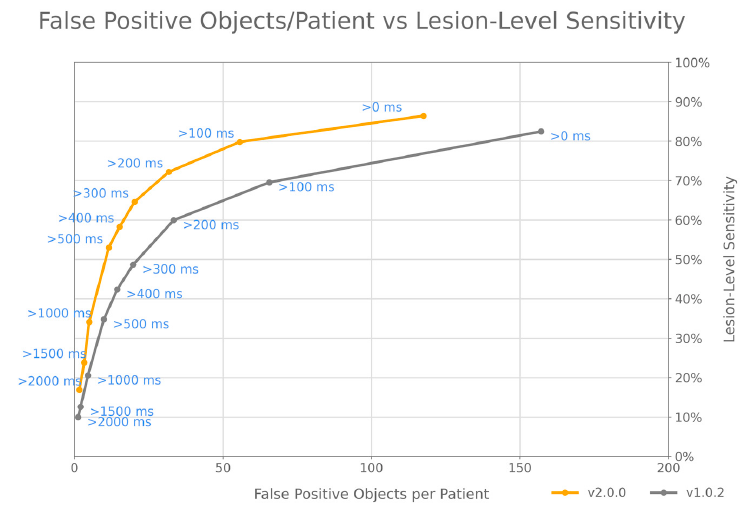
Figure 3. fROC analysis has to be extended to describe lesion-level sensitivity and cluster-based FP object definitions, to compare the performances of different CADe modules for polyp detection. The fROC curves displayed in the figure show the performances of GI Genius CADe v1 and v2 on the holdout test set used in Hassan et al. [14].